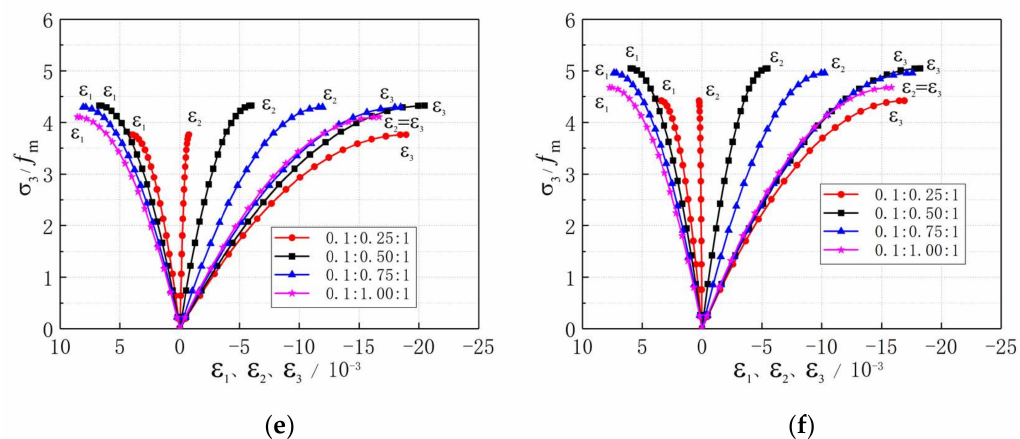
Figure 3. The stress-strain curves for SSC under triaxial compression: ( a ) σ 1 : σ 3 = 0.05:1, SSC-30; ( b ) σ 1 : σ 3 = 0.05:1, SSC-70; ( c ) σ 1 : σ 3 = 0.05:1, SSC-100; ( d ) σ 1 : σ 3 = 0.1:1, SSC-30; ( e ) σ 1 : σ 3 = 0.1:1, SSC-70; ( f ) σ 1 : σ 3 = 0.1:1,